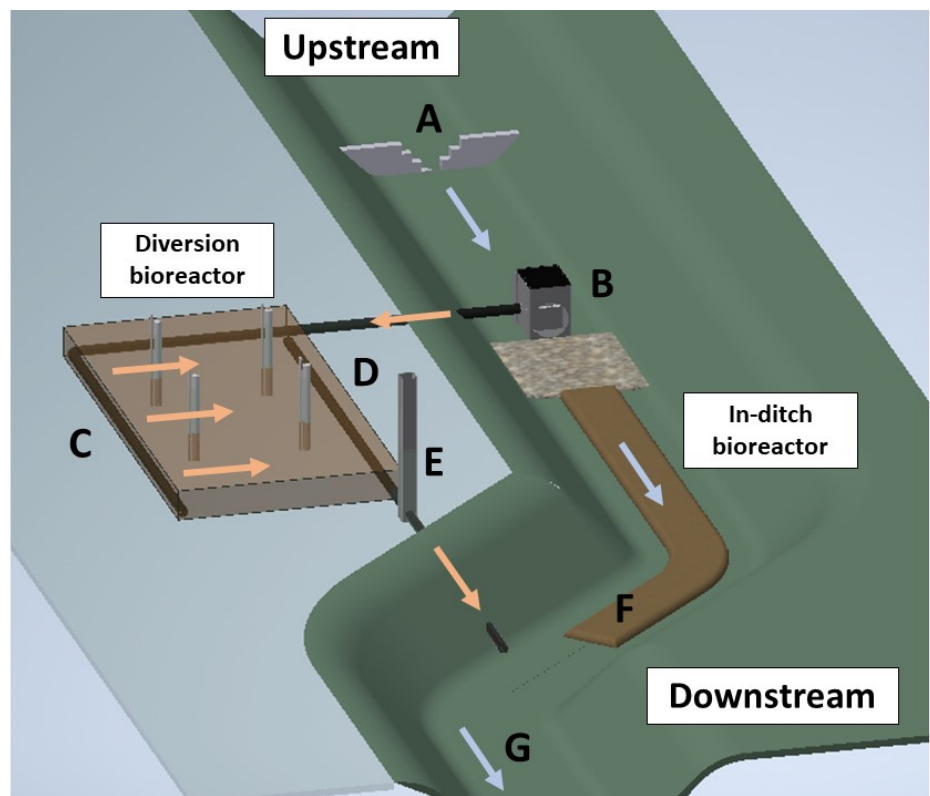
Figure 1. The paired bioreactor system with in-ditch and diversion bioreactor on adjacent bank. Flow entered the paired system through the cinder block weir ( A ). Surface water entered the diversion bioreactor through the in-ditch riser structure ( B ), flowed from the inlet flow manifold ( C ) to the outlet flow manifold ( D ), and exited through the outlet water level control structure ( E ). Water samples for measuring nitrate entering the bioreactors were collected at Point A. Water samples measuring nitrate leaving the diversion and in-ditch bioreactor were collected at Points E and F, respectively, and at Point G to determine total nitrate removal by the paired system.